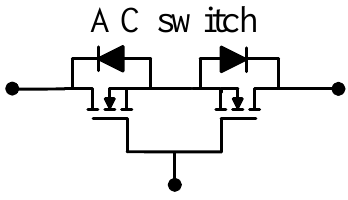
Figure 11. ACSs with two MOSFETs connected back-to-back.